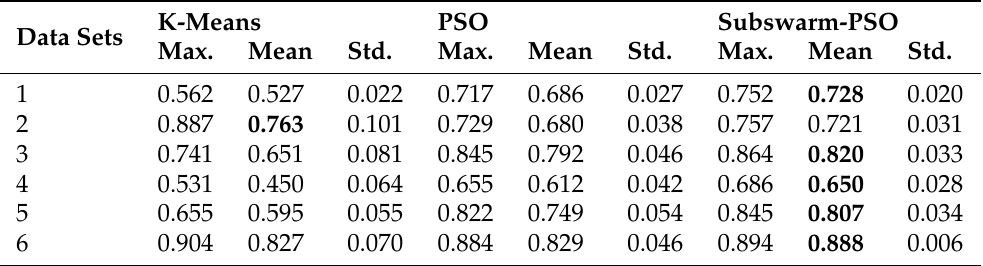
Table 5. Maximum, mean, and standard deviation results for all iteration numbers for clustering algorithms for six data sets.